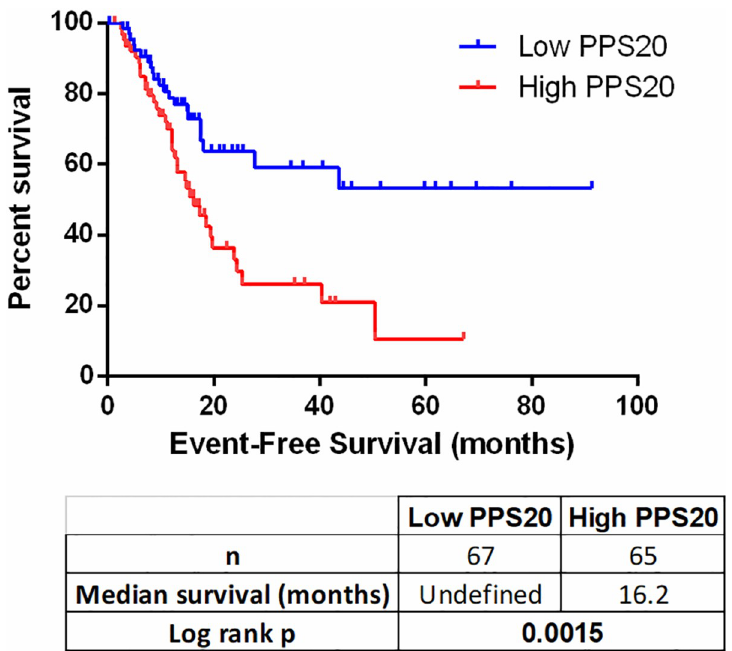
Fig 3. PPS20 can predict event-free survival. Kaplan Meier graph based on PPS20 in TCGA PAAD tumors. Statistics are given below the figure.